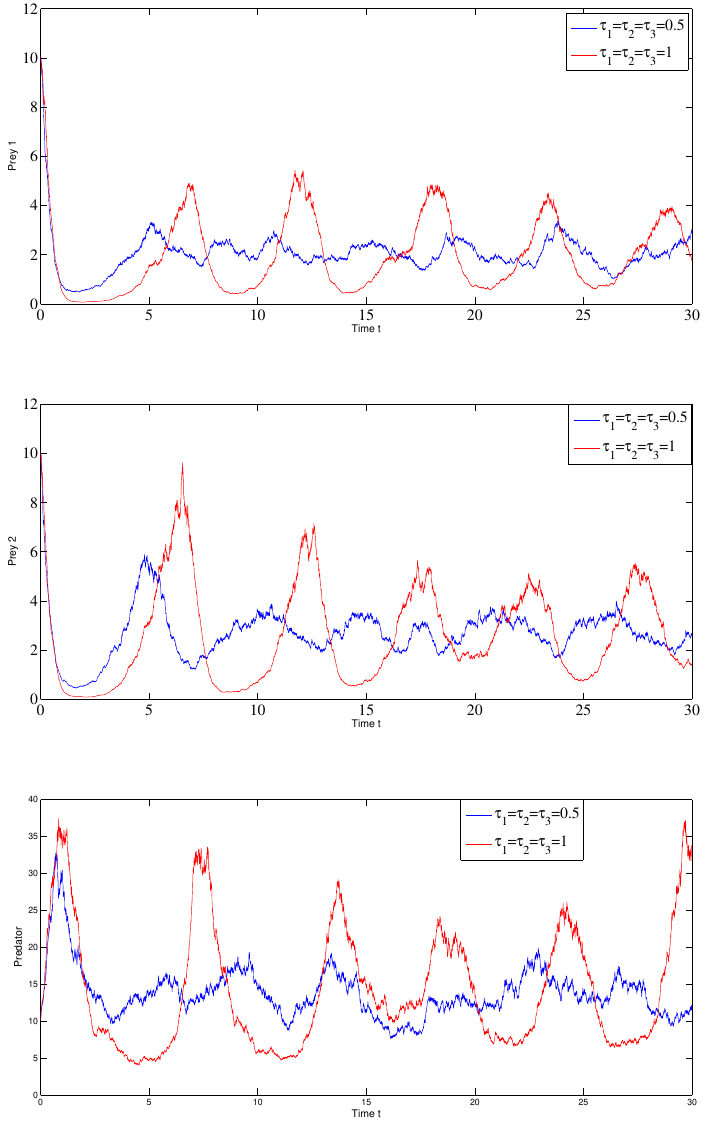
Figure 9. The behavior of the populations for different values of τ 1 , τ 2 and τ 3